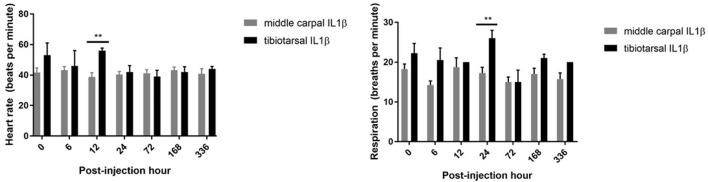
Heart rate and respiratory rate of horses prior to and following rIL-1β administration into the middle carpal joint and tibiotarsal joint. An increase in mean heart rate and respiratory rate is seen in horses receiving rIL-1β into the TTJ at 12 and 24 h, respectively, when compared to the MCJ. Error bars represent that standard error of the mean (SEM) and significance is indicated by **(P < 0.01).